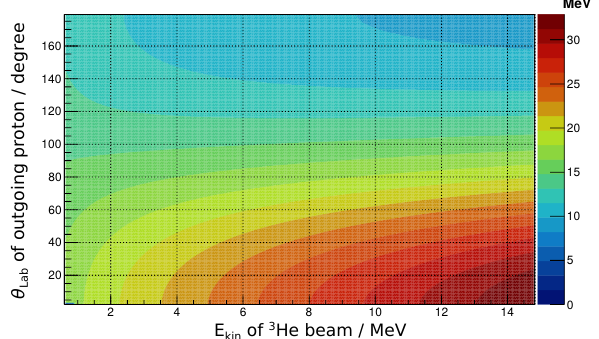
Figure 3. Kinetic energy of the outgoing protons from the d - 3 He fusion reaction vs. 3 He beam energy and proton polar angle in the Lab frame.